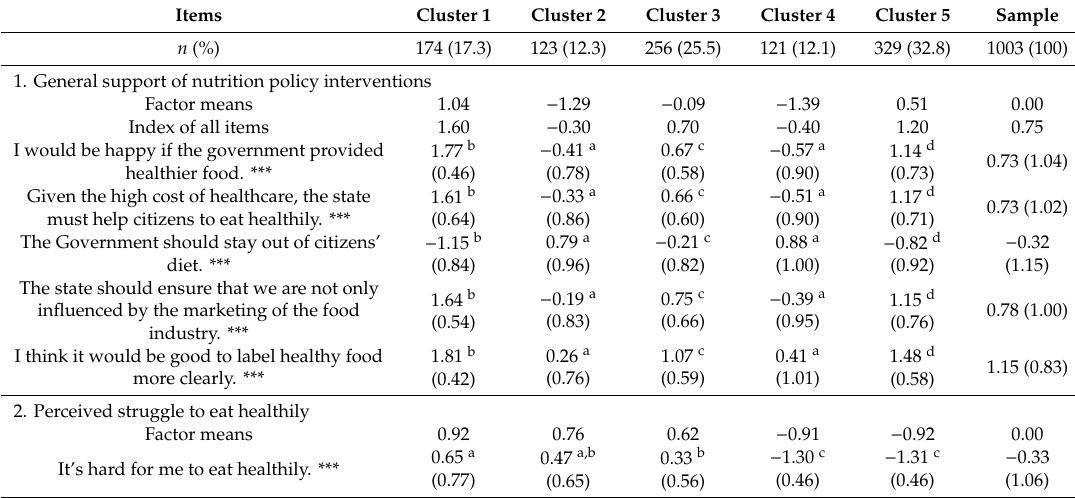
Table 4. Means of the cluster-building